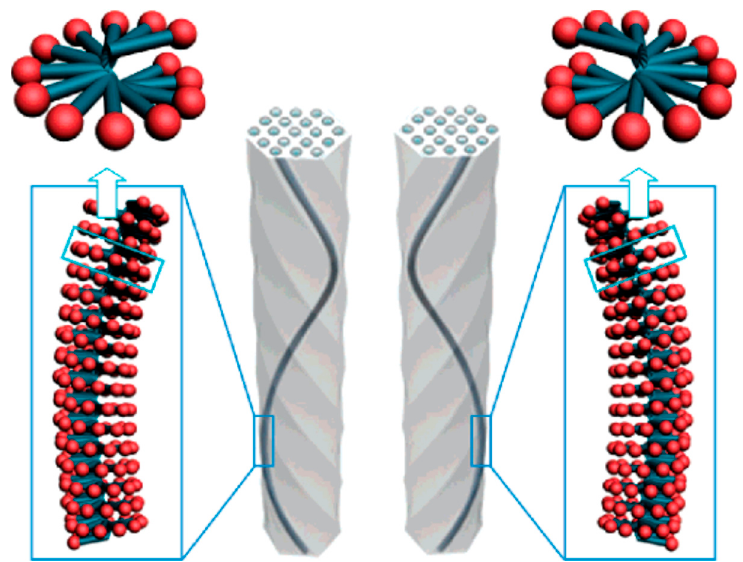
Figure 2. Molecular origin of the left-handed ( left ) and right-handed ( right ) helical structure of the CMS derived from the helical propellerlike packing of the chiral amphiphilic molecules. Credit: reprinted with permission from Reference [37]. Copyright 2008 American Chemical Society.